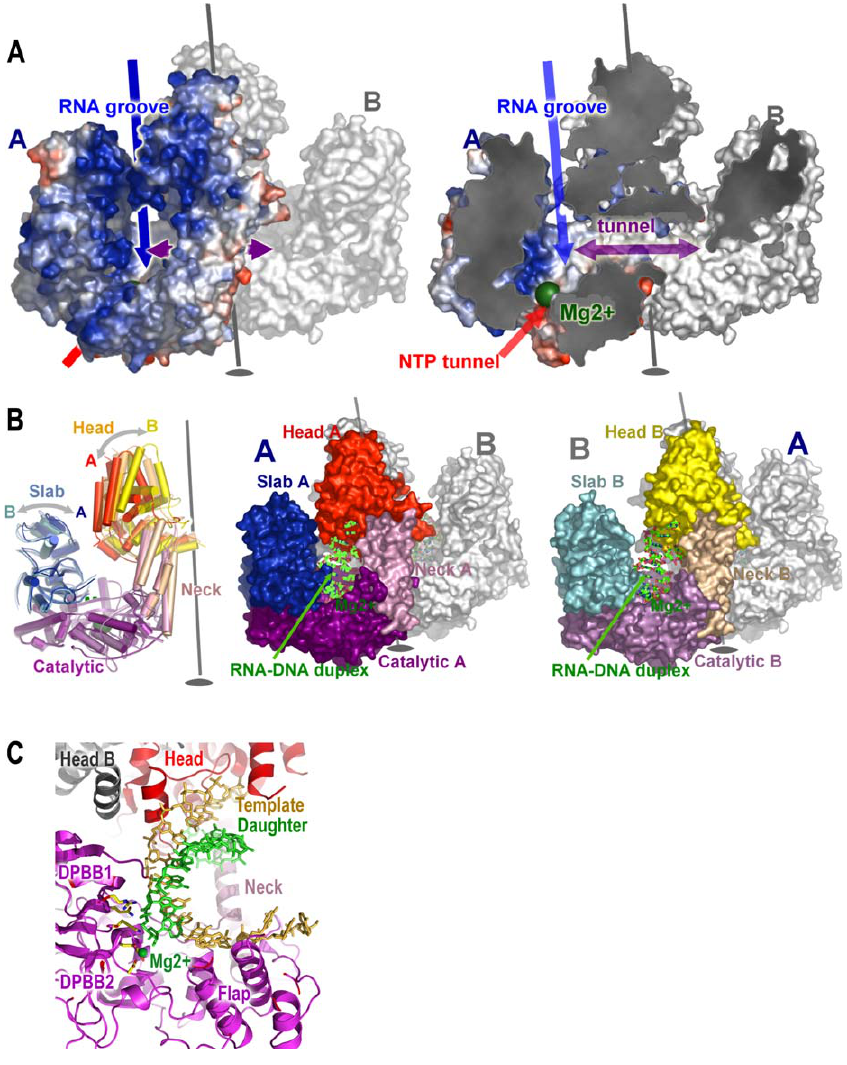
Figure 2. QDE-1 D N Surface Architecture (A) Surface charge representation of subunit A of QDE-1 D N (subunit B coloured grey). Blue arrow indicates proposed RNA product groove; red arrow indicates proposed NTP tunnel; and purple arrow indicates tunnel linking active sites in the dimer. The Mg 2 þ ions are shown as green spheres. Left panel: dimer (view similar to Figure 1A). Right panel: sliced view of left panel to reveal the tunnels. (B) Different conformations of QDE-1 D N subunits modify polymerase active site accessibility. Left panel: cartoon representation of superposition of observed subunit conformations, coloured according to domain definition: subunit A as in Figure 1A; subunit B: slab, cyan; catalytic, magenta; neck, wheat; and head, yellow; C2 crystal form subunit (semi-transparent): slab, marine; catalytic, violet; neck, light salmon; and head, orange. In all panels, Mg 2 þ ions are represented as green spheres. The direction of the movement of the slab and head domains is indicated by grey arrows, and the non- crystallographic 2-fold is shown. Central and right panels: RNA-DNA duplex (from an elongation complex of yeast RNApolII) fitted (using the operators for superposition of yeast RNApolII onto QDE-1) into QDE-1 D N closed and open subunits (represented as molecular surfaces). Centre panel colours subunit A (closed conformation). Right panel shows a view rotated by 180 8 with subunit B (open conformation) coloured. RNA-DNA duplex model is show in ball-and-stick representation. (C) Close-up of the duplex model from (B). Domains are coloured as for the central panel of (B). The slab domain of molecule A would lie across the front of the figure and has therefore been removed for